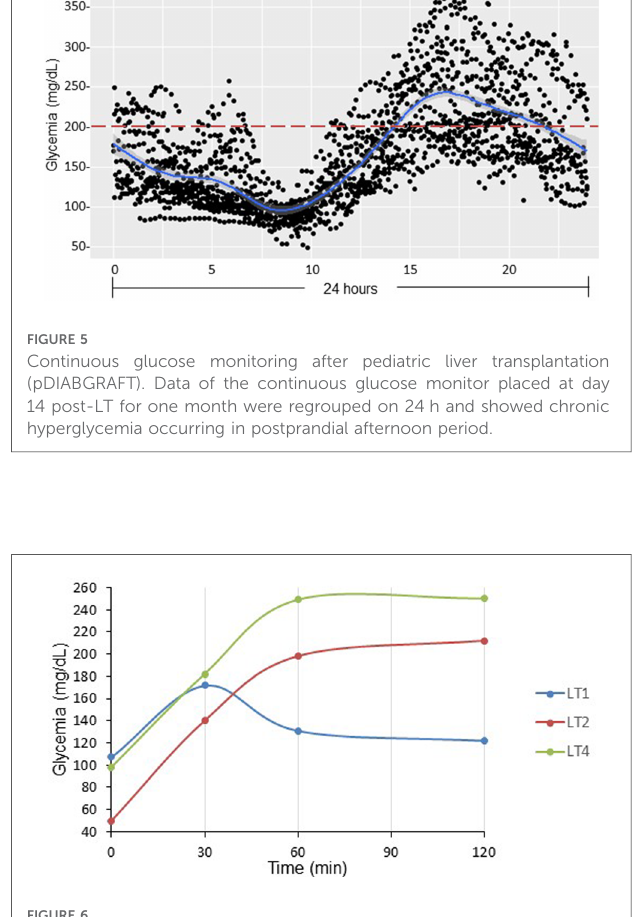
FIGURE 6 OGTT at one-month post liver transplant children (pDIABGRAFT). The oral glucose tolerance test (OGTT) performed at one-month post LT showed that fasting glucose were in the normal range whereas for two of them glycemia peaked respectively at 212 (LT2) and 250 (LT4) mg/dl at the end of the test (120 ′ ), corresponding to overt diabetes.